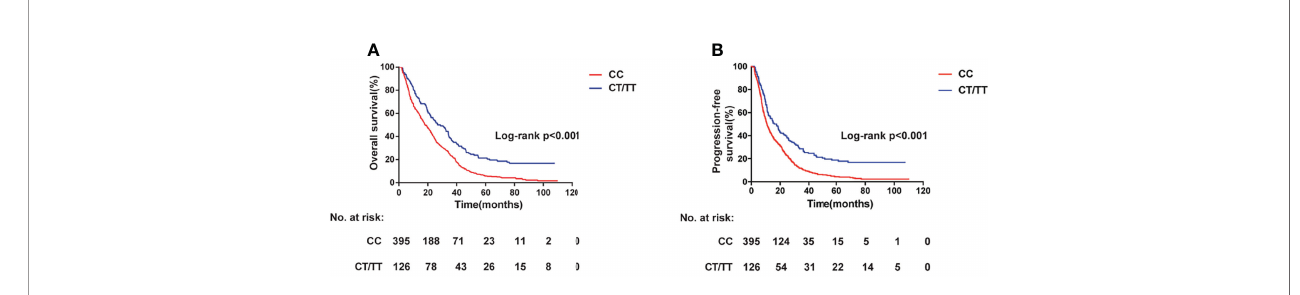
FIGURE 2 | PVT1 rs2278176 genotypes and colorectal cancer: overall survival (A) and progression-free survival (B) (log-rank P <